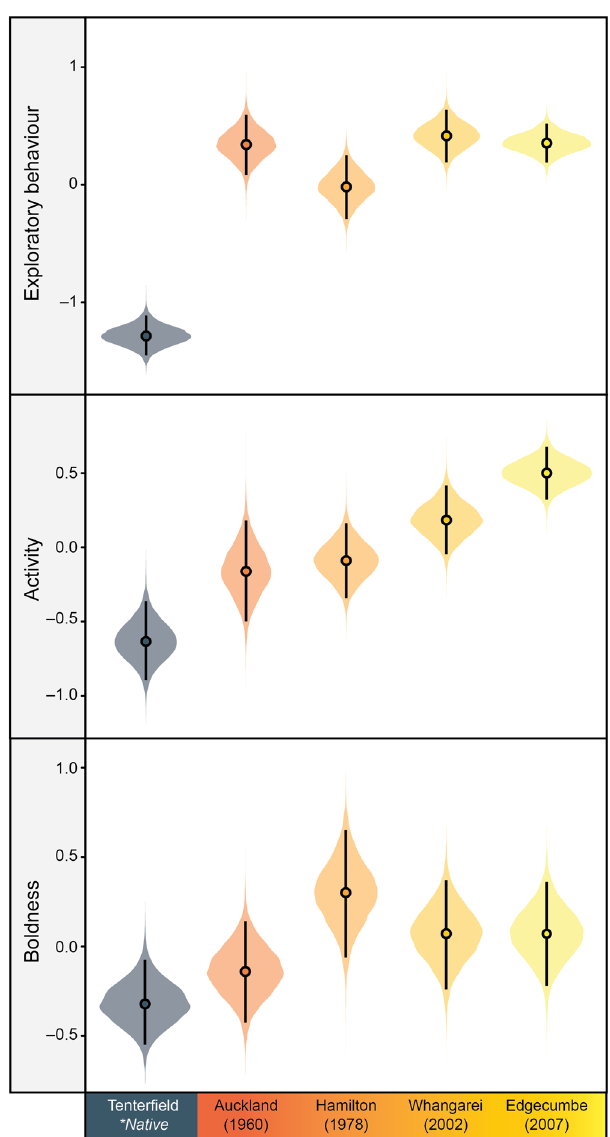
Fig. 3 | Differences in average-level exploratory behavior (i.e., time spent exploring the barrier), activity (i.e., number of transitions between grid squares), and boldness (i.e., re-emergence latency; axis inverted) between the native Tenter fi eld source population (grey; n =30 skinks), and invasive New Zealand skinks from Auckland (red; n =31), Hamilton (orange; n =43), Whan- garei (light-orange; n =33), and Edgecumbe (yellow; n =36). Boldness scores were inverted so that higher values represent bolder lizards. All behavioral scores are presented in standardized units. For each graph, fi lled circles represent pos- terior medians, vertical error bars denote 95% credible intervals, and plot width represents probability density. Source data are provided as a Source Data fi